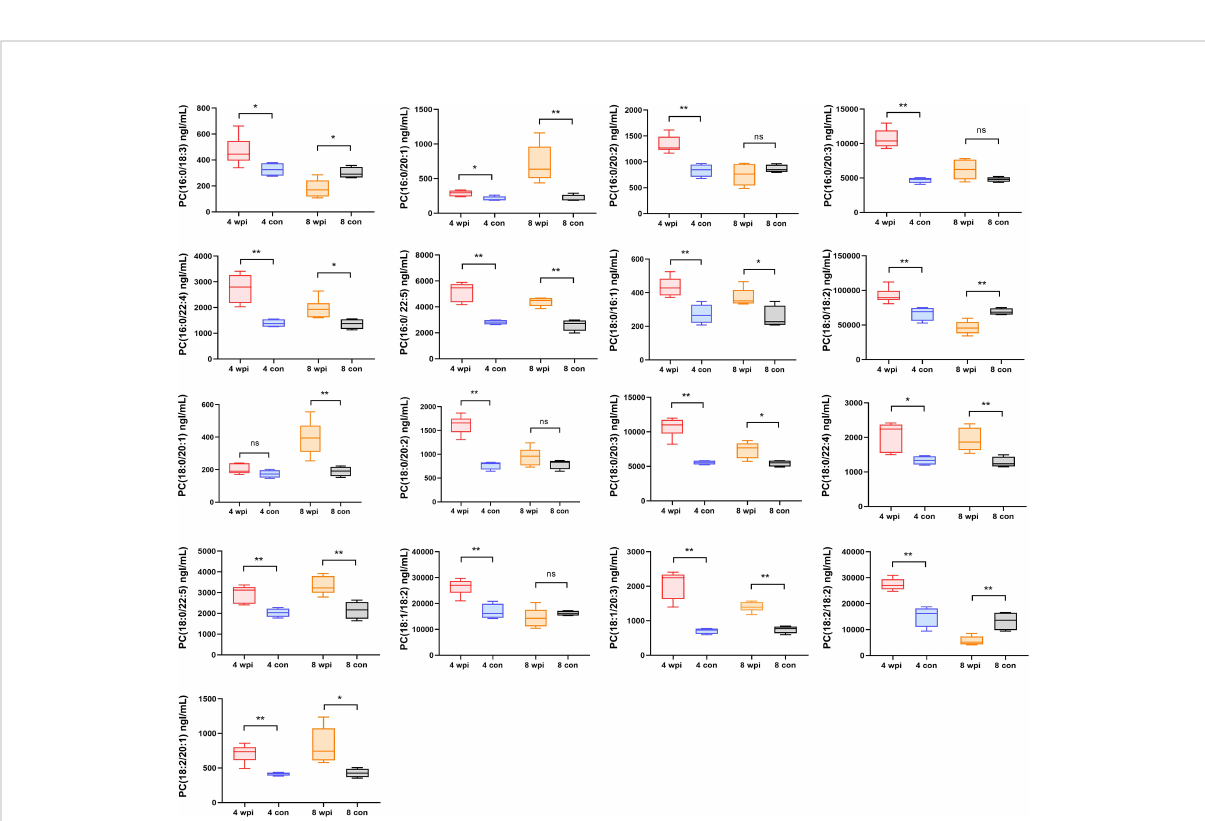
FIGURE 5 The concentrations of 17 phosphatidylcholines in serum of different groups. * P < 0.05, ** P < 0.01, t -test. ns, no signi fi cant